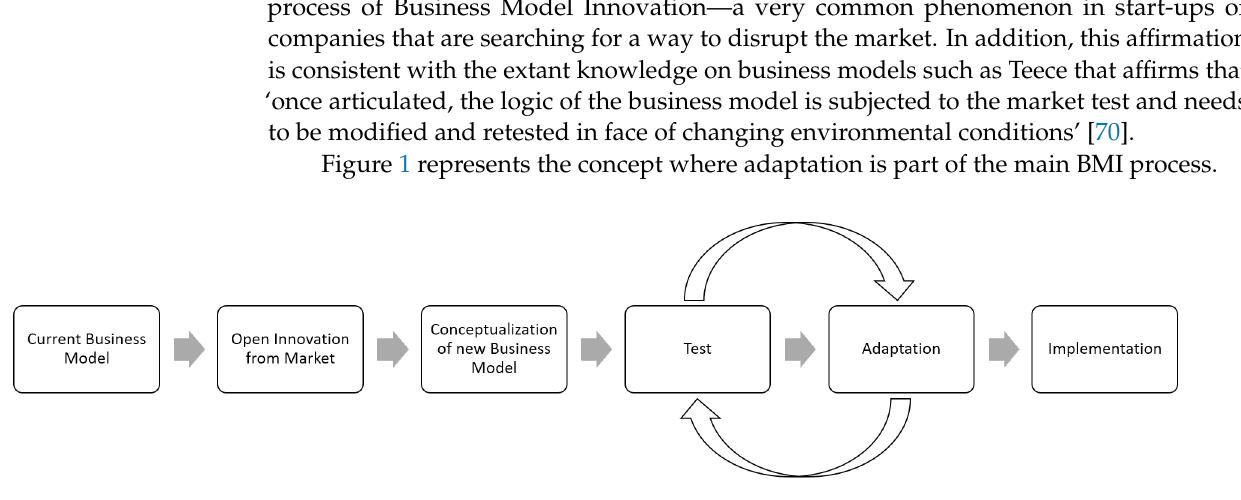
Figure 1. Business Model Innovation process adapted from Chesbrough and Rosenboom [28].